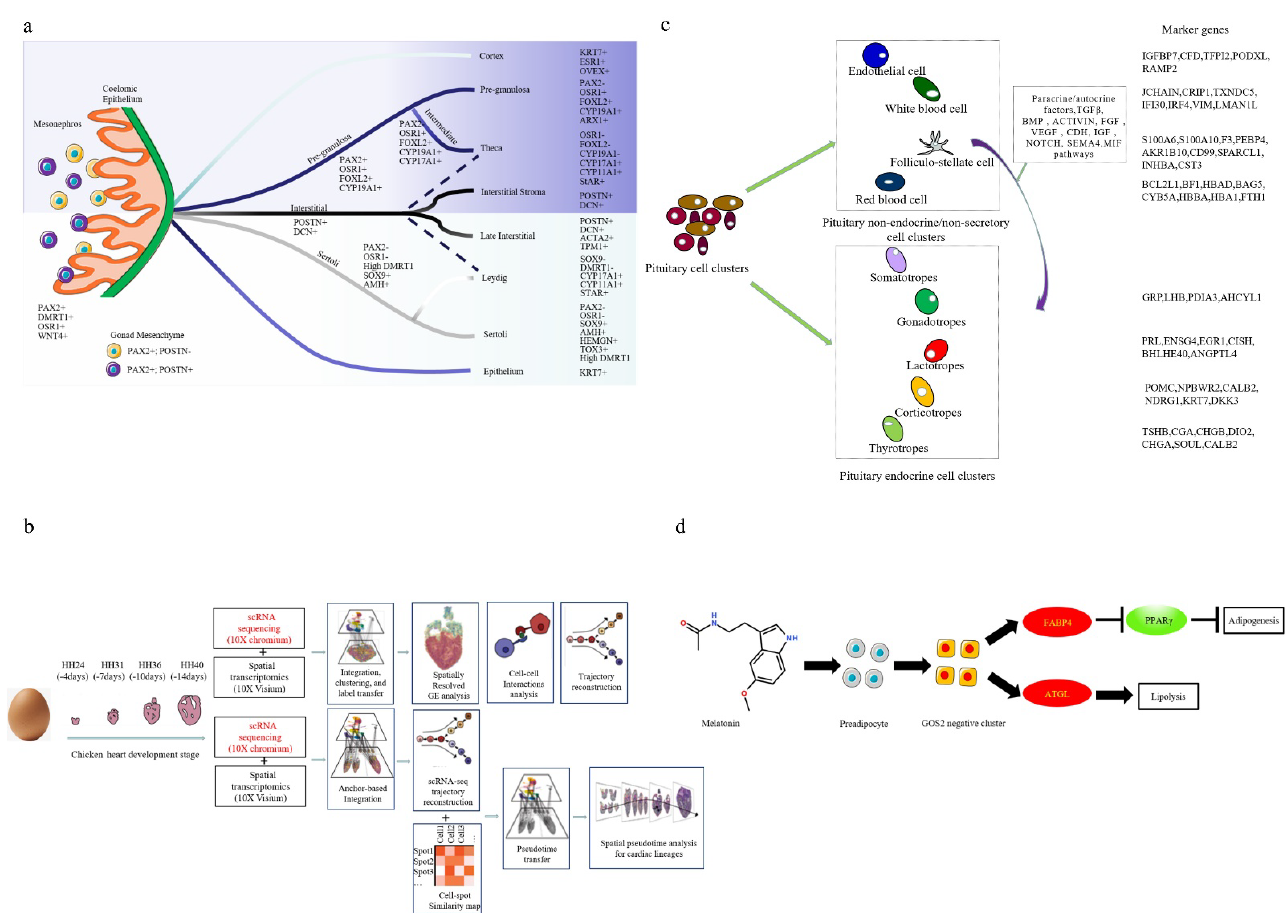
Figure 3. Application of SCS in poultry organ and limb development. ( a ) Schematic representation of cell lineage specification in the embryonic chicken gonad. ( b ) Analysis for scRNA-seq and spatial RNA-seq of embryonic chicken hearts at four stages of development, and schematic representation of cell lineage specification in the embryonic chicken gonad. ( c ) Chicken pituitary cell heterogeneity. ( d ) Schematic representation showing that melatonin induced preadipocyte cell fate heterogeneity and contributed to